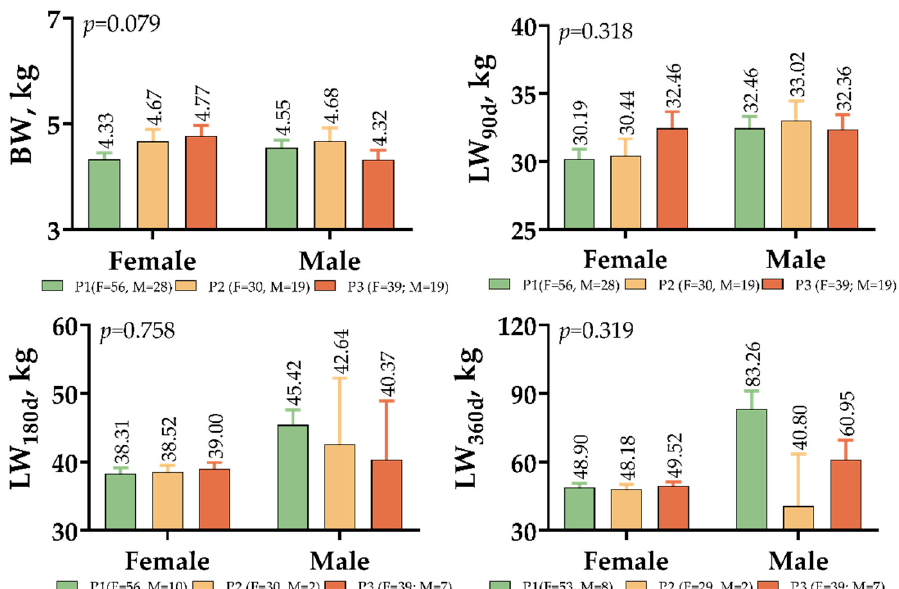
Figure 2. Effects of GHE5 polymorphism on live weight at different periods. BW: Birth weight, LW: Live weight .